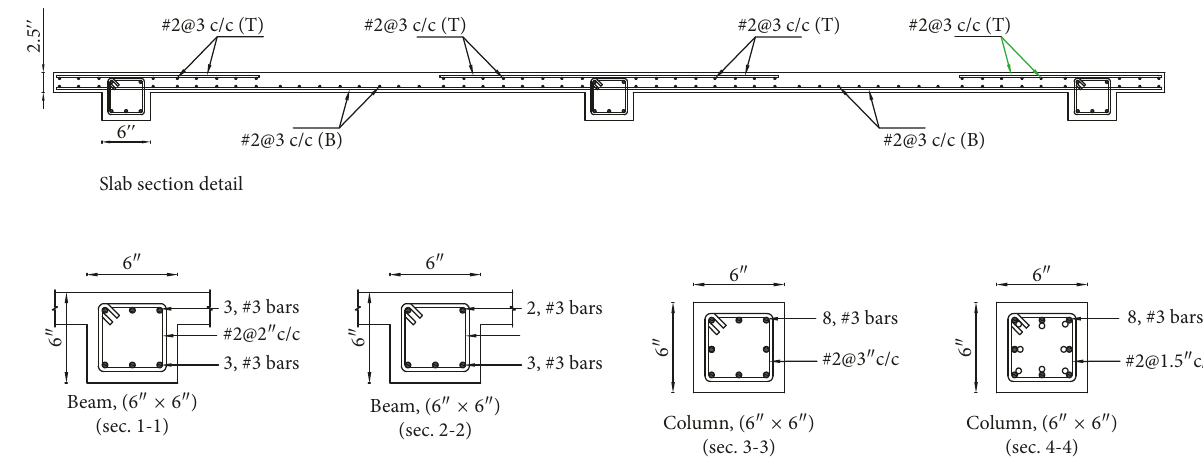
Figure 5: Cross-sectional detail of the RC frame (dimensions in inches).